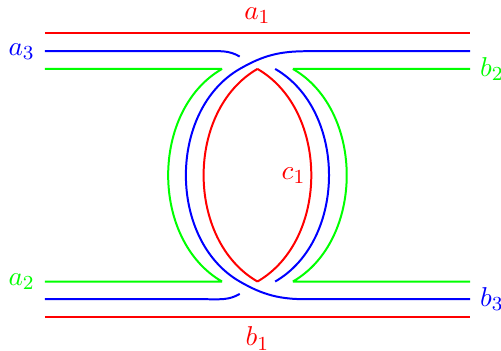
Figure 5 . The one-rung ladder supergraph computing the matrix M in (4.51) in the triple-line